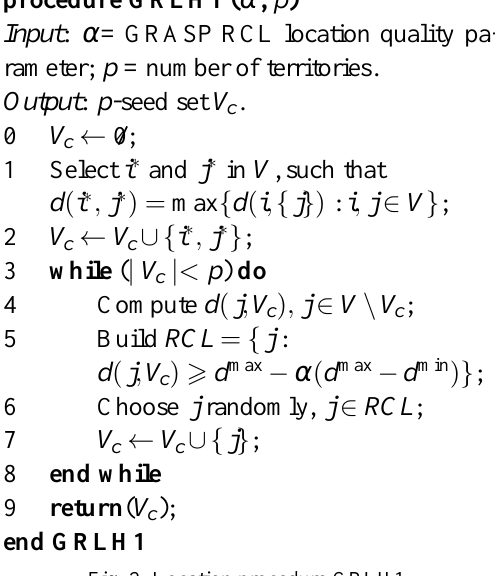
Fig. 2. Location procedure GRLH1.